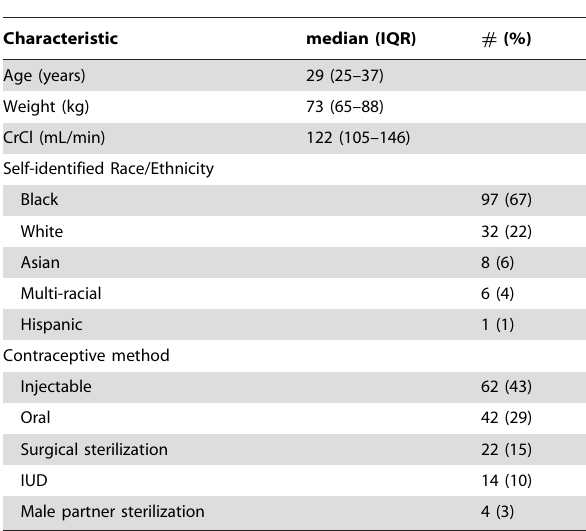
Table 2. Subject